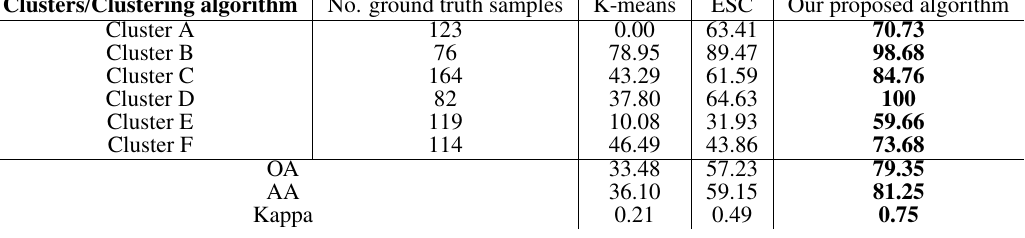
Table 2. Quantitative assessment on the performances of the clustering algorithms applied to Scene No.2. The clustering performance is evaluated using overall accuracy (OA), average accuracy (AA), and Kappa